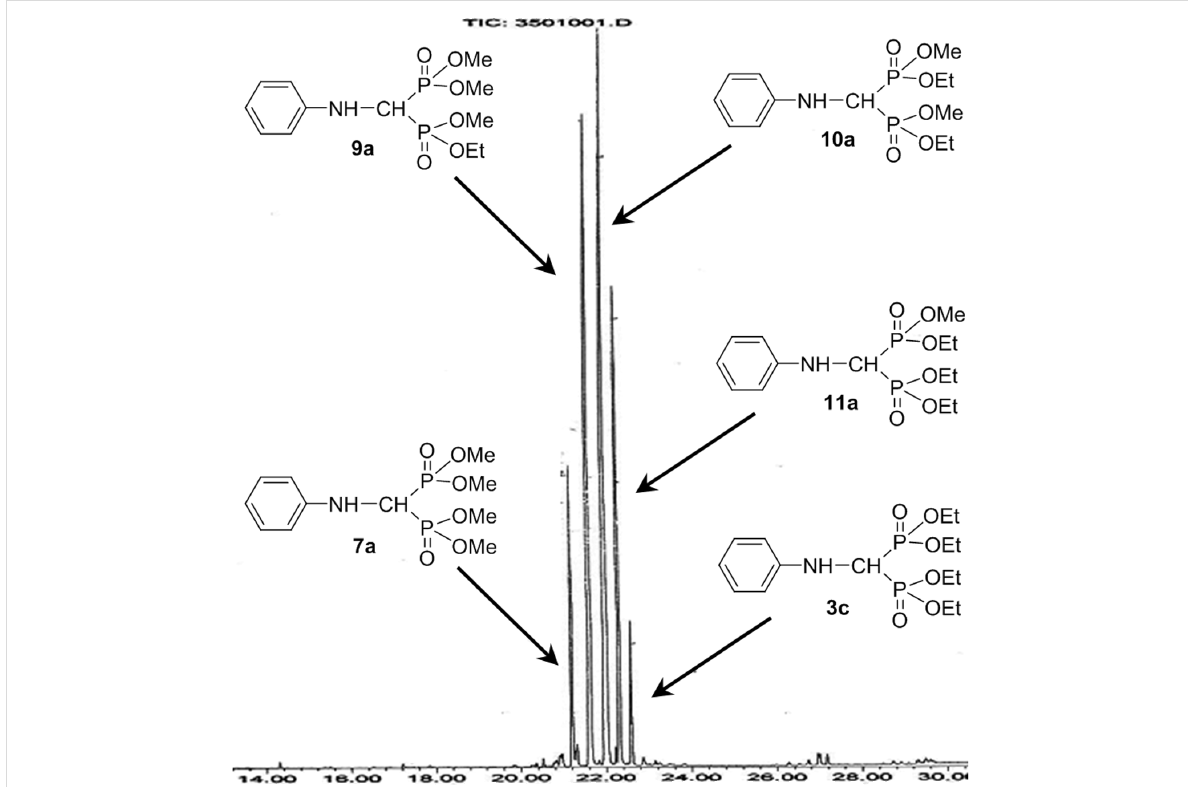
Figure 2: GC–MS chromatogram for the condensation of aniline, triethyl orthoformate and 2 equivalents of dimethyl phosphite (from the exp. marked by Table 6, entry 1).